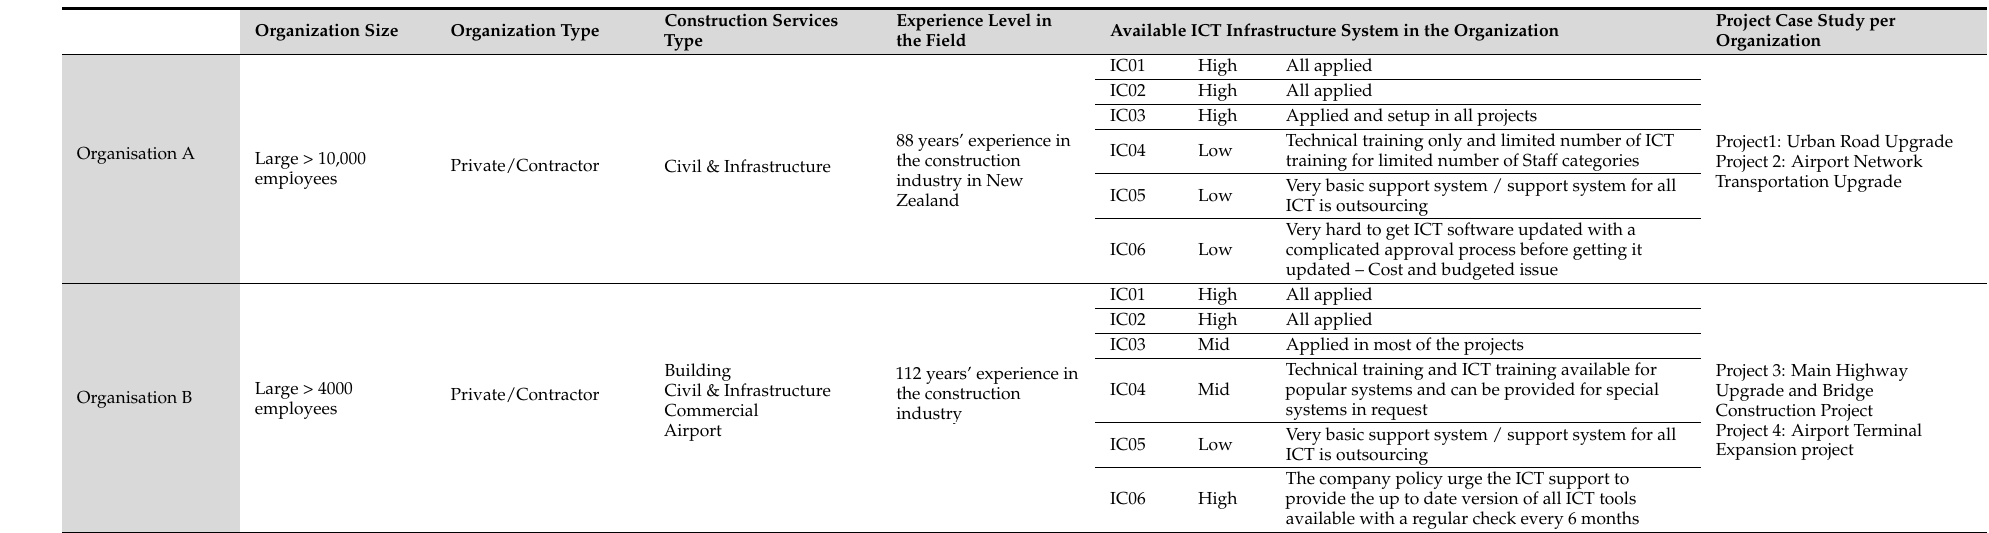
Table 2. The organizational ICT infrastructure availability for each case